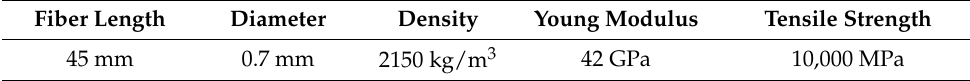
Table 2. Material characteristics of basalt